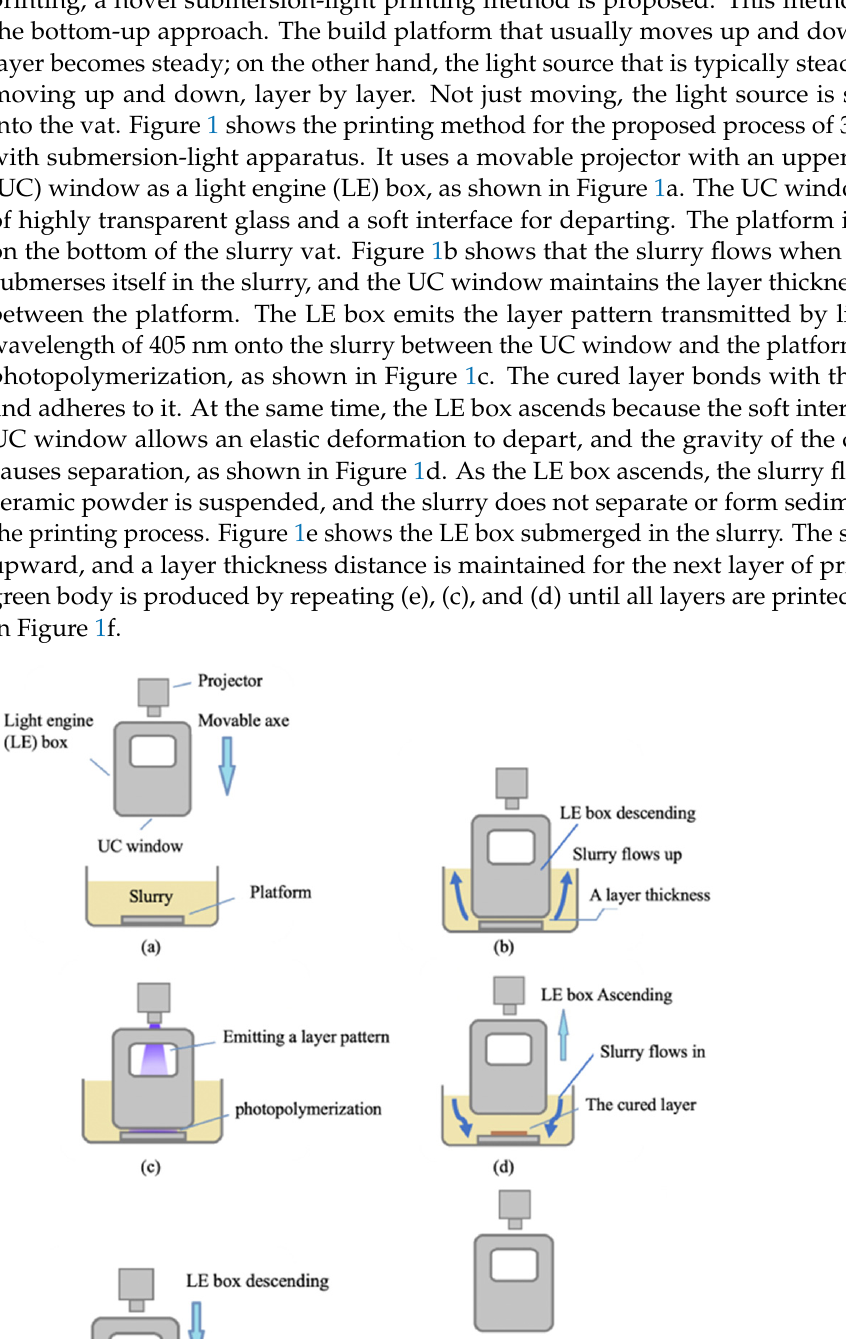
Figure 1. ( a – f ) The principle of the submersion-light 3D slurry printing method .